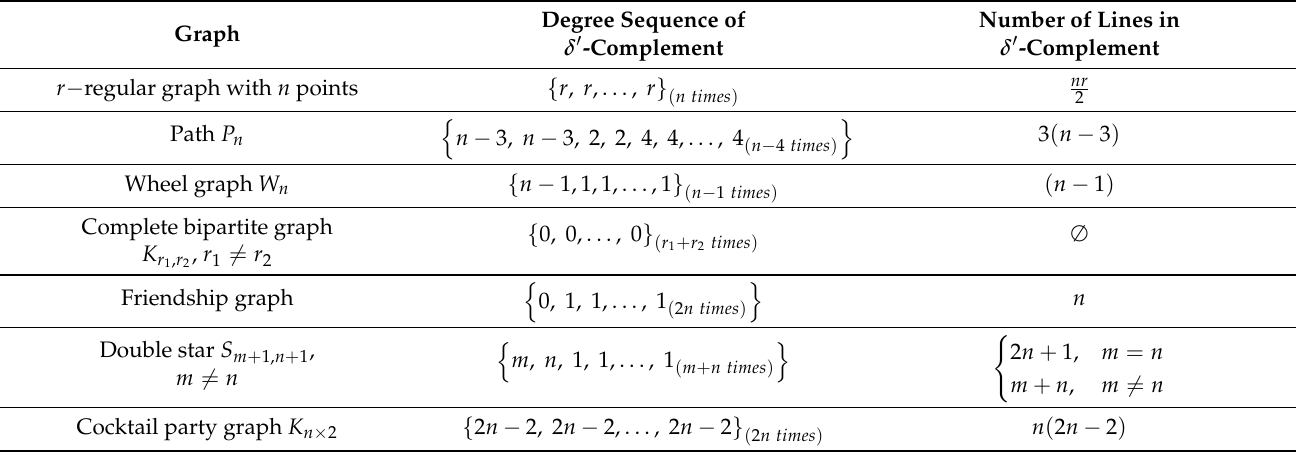
Table 2. The degree sequence and number of lines of δ (cid:48) -complement for different